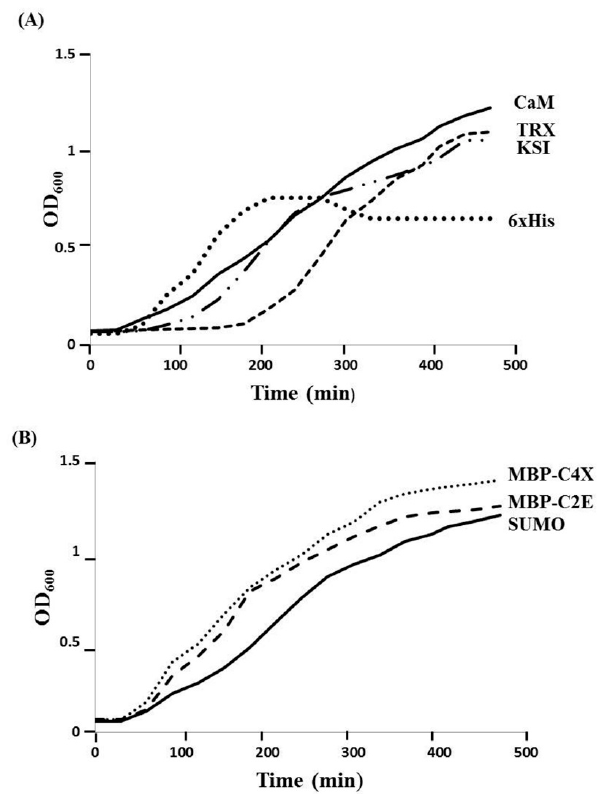
Figure 1. The effect of IPTG-induced MIP-3 α expression with various fusion systems on the growth of the E. coli BL21 (DE3), and Origami (DE3) host cells. ( A ) The growth curves obtained with pET15b-CaM-MIP-3 α (solid line), pET19b-6 × His-MIP-3 α (round dot), and pET32a-TRX-MIP-3 α (dashed line), pET19b-KSI-MIP-3 α (long dash-dot-dot), and ( B ) The growth curves obtained with pET-SUMO-MIP- 3 α (solid line), pMAL-C4X-MIP-3 α (round dot), pMAL-C2E-MIP-3 α (dash line) are also shown for comparison. E. coli cells were grown in 5 mL of LB medium at 37 °C and induced with 0.5 mM IPTG at an OD 600 ~ 0.65.